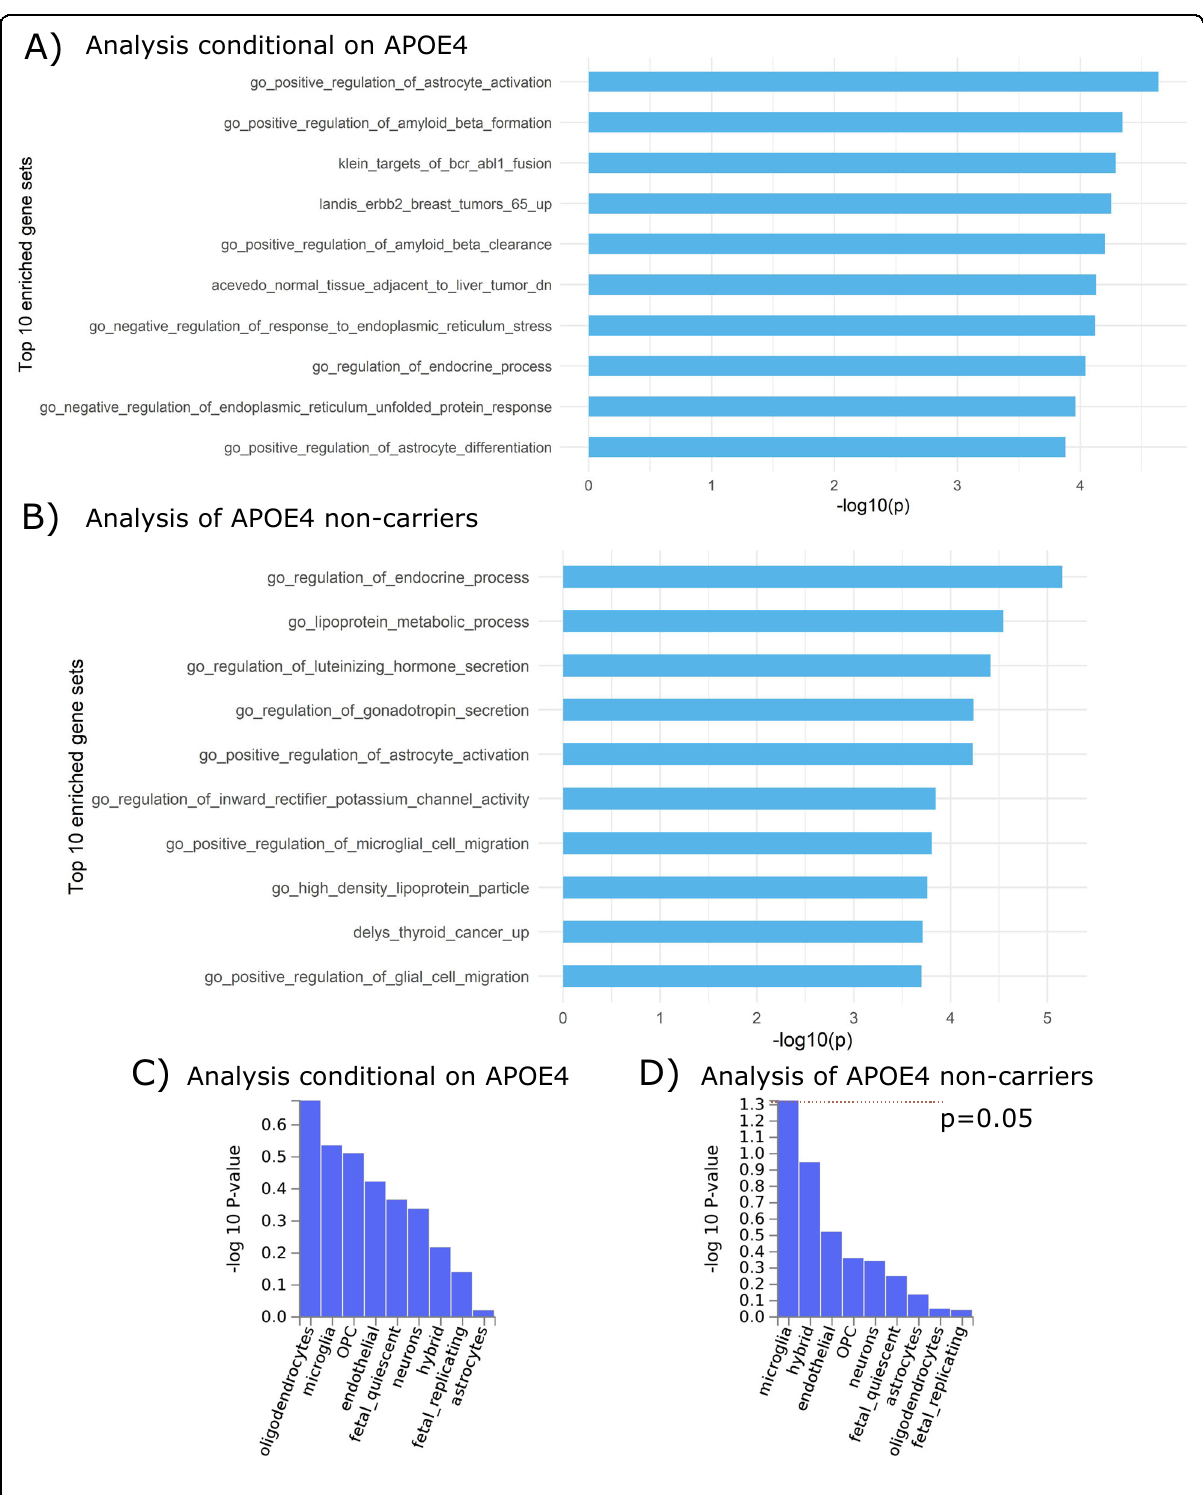
Fig. 5 Top ten gene sets enriched in the results of the exome-wide association analyses of age-of-onset of AD. A Enrichment using the summary statistics from Model 2: a Cox model with all subjects in the ADSP project adjusted for the copies of APOE ε 4 ; B Enrichment using the summary statistics from Model 3: a Cox model with only APOE ε 4 non-carriers. Cell-type enrichment analysis of major neural cell types based on the summary statistics from the exome-wide association analyses of age-of-onset of AD using C Model 2 and D Model